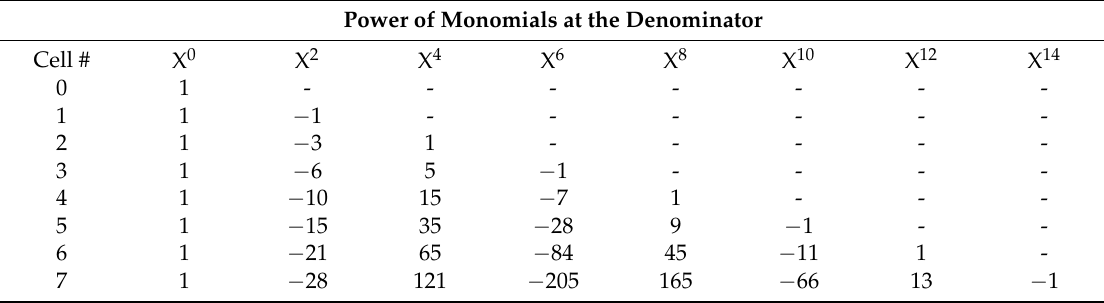
Table 1. DFF triangle for a seven-cell L.N.